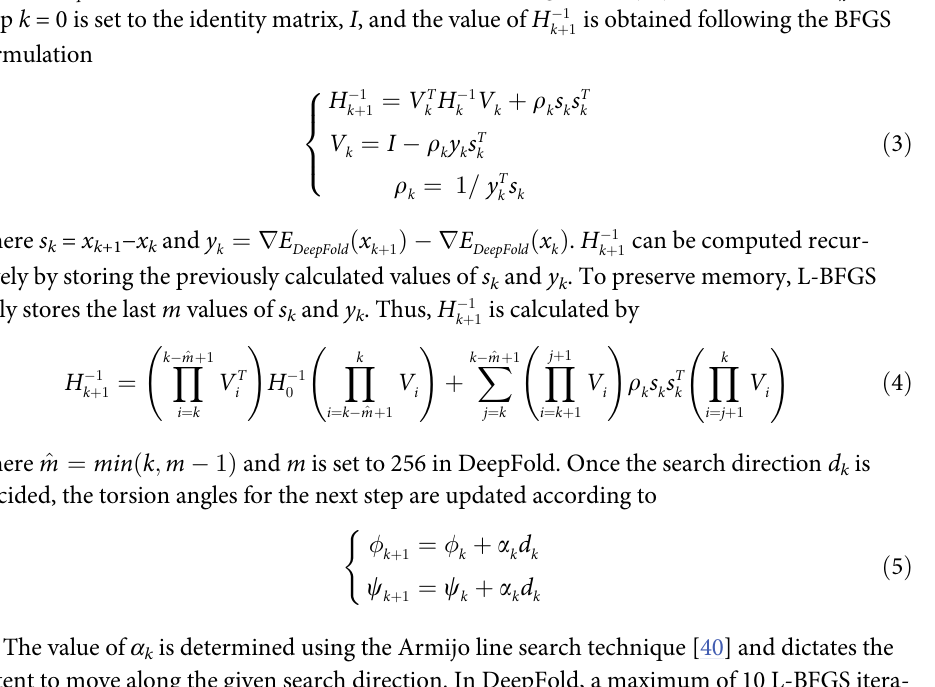
S1 Table. Impact of the different components of the DeepFold energy function on the structure modeling accuracy. S2 Table. Mean absolute error (MAE) between the top specified number of long-range dis- tance restraints predicted by DeepPotential and the models built without (GE+Cont+Dist) and with (GE+Cont+Dist+Orien) inter-residue